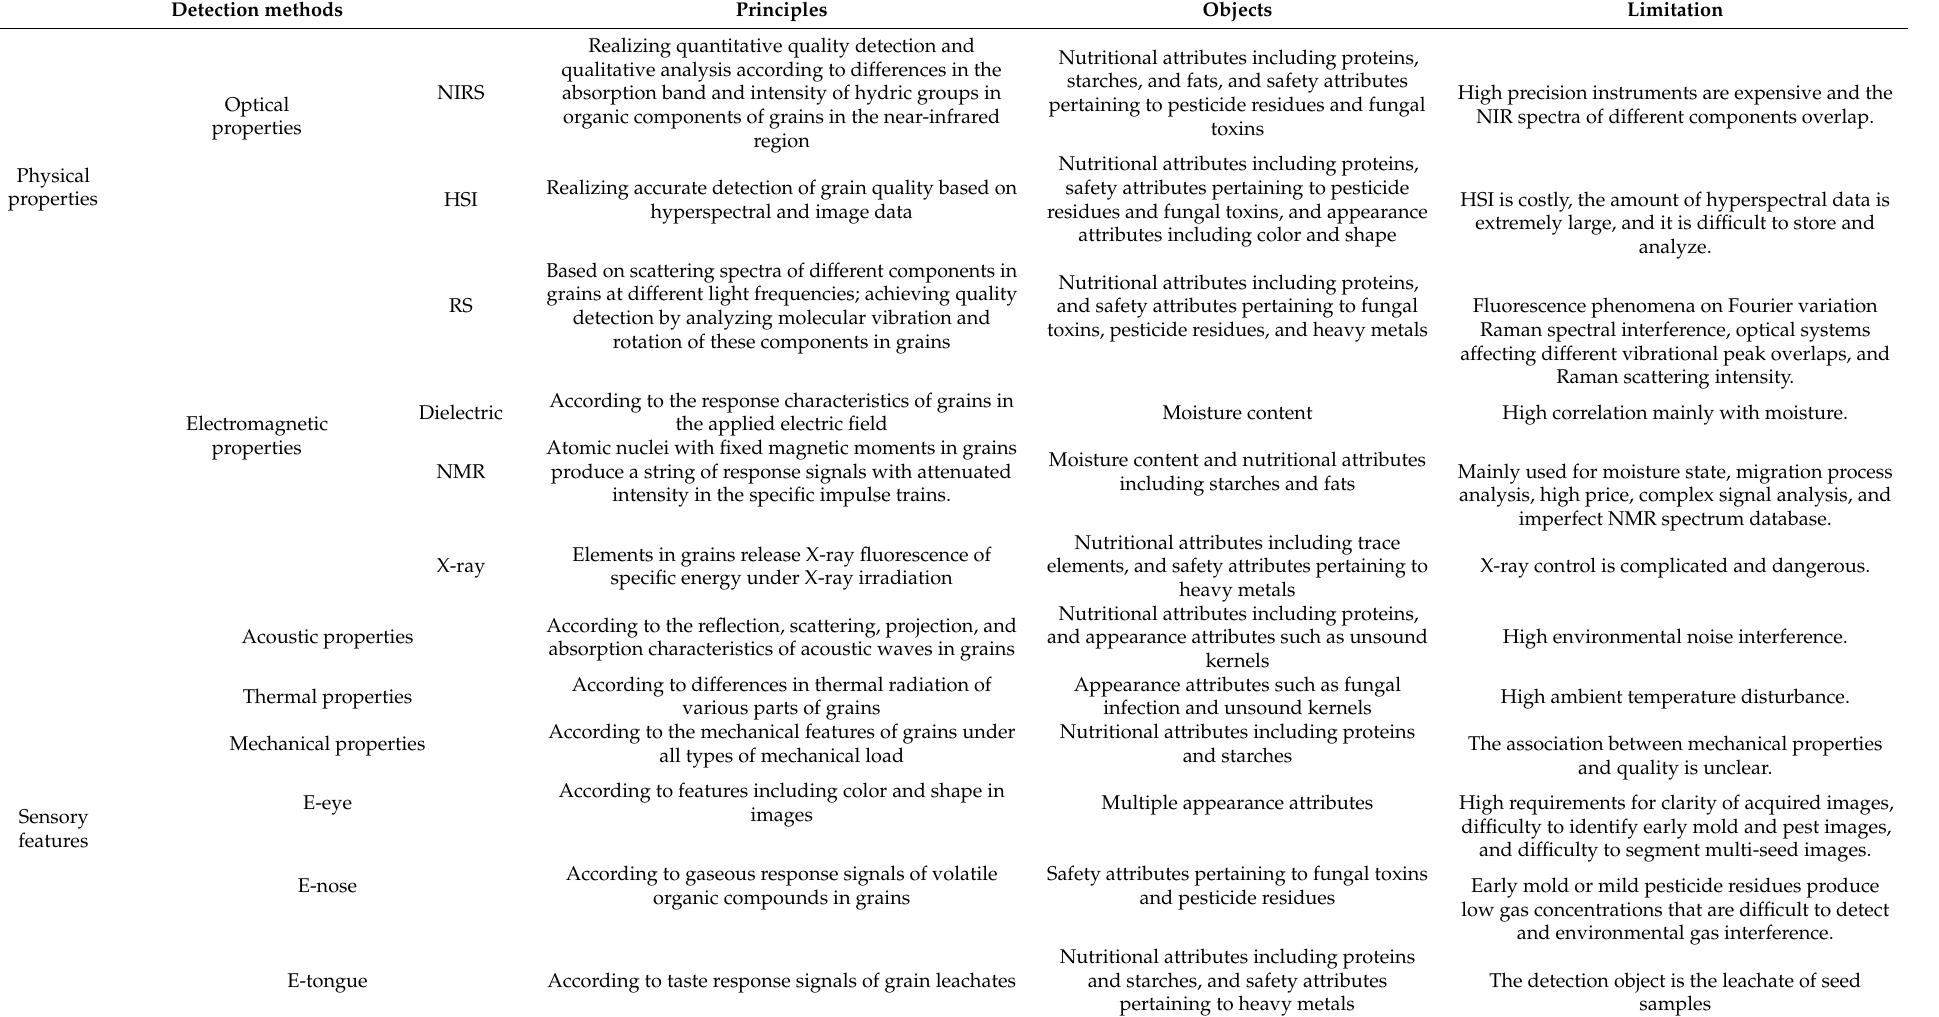
Table 1. Modern inspection techniques for grain